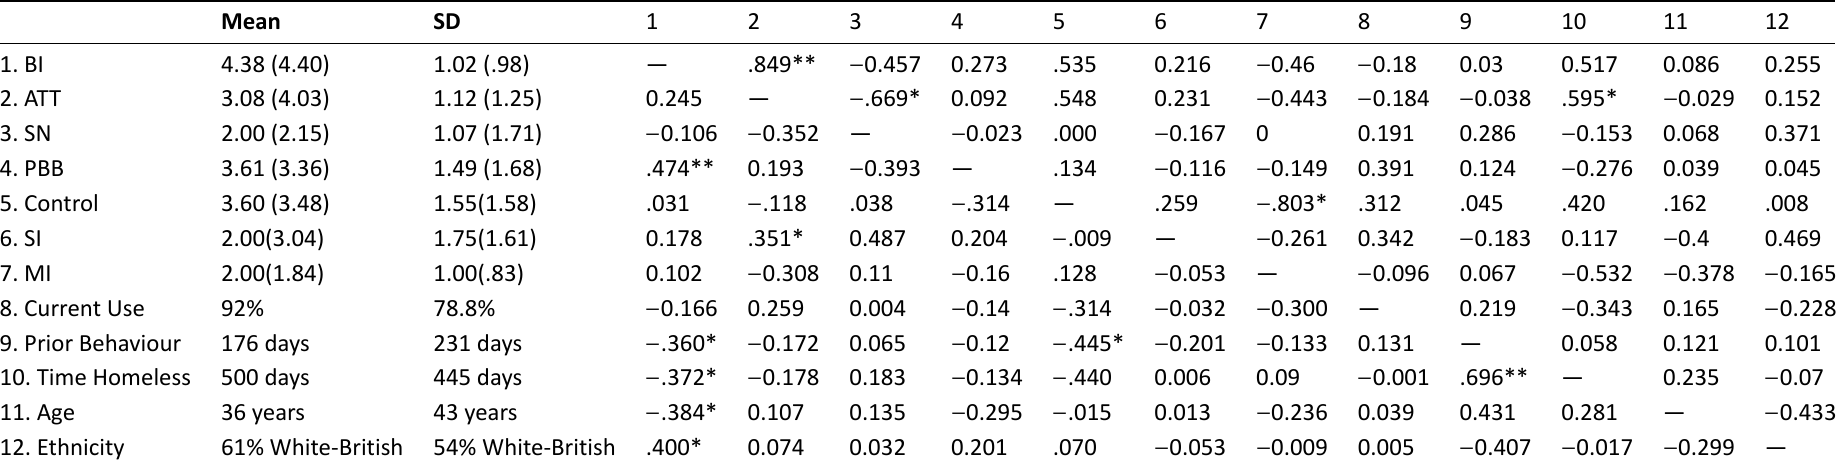
Table 2. Descriptive statistics and intercorrelations for high and low prior service use populations: High prior use above diagonal ( n = 13) and low prior use below diagonal ( n =